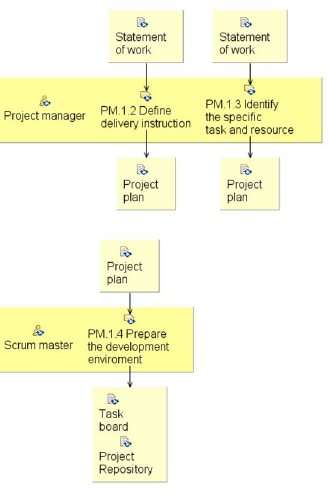
Figure 15. The detailed activity diagram of the planning process.